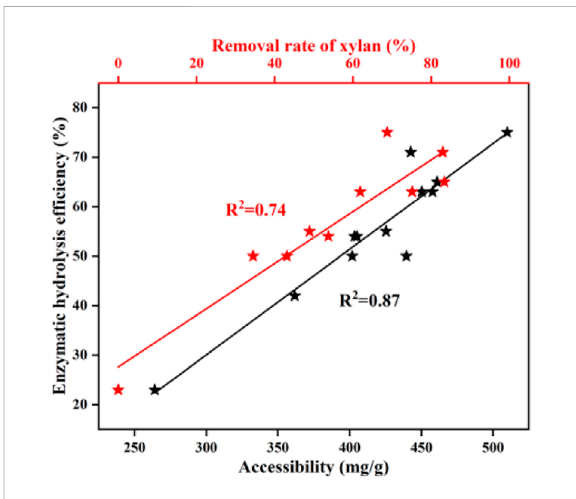
FIGURE 2 Relationships between the structural properties and the ef fi ciency of the enzymatic hydrolysis of pretreated